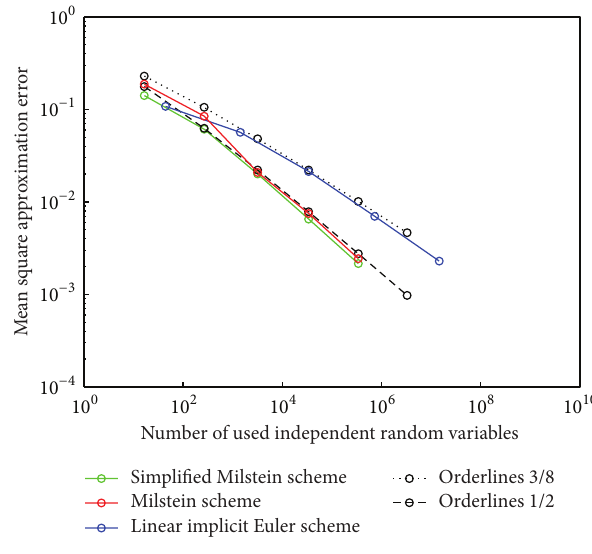
Figure 1: Approximation error in the sense of (22) of the linear implicit Euler and simplified Milstein and Milstein type